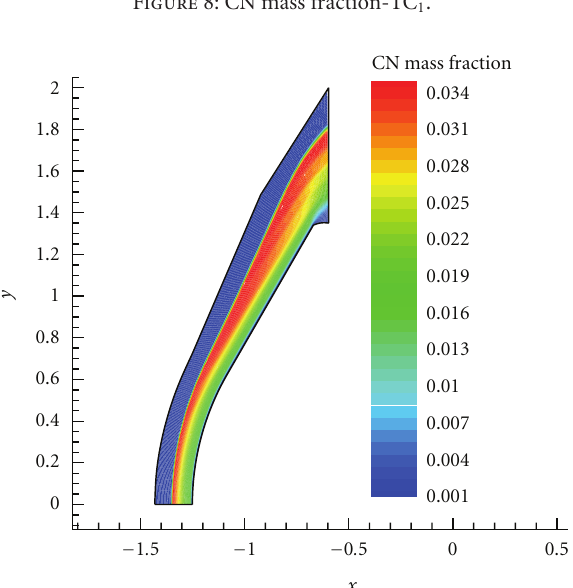
Figure 8: CN mass fraction-TC 1 .